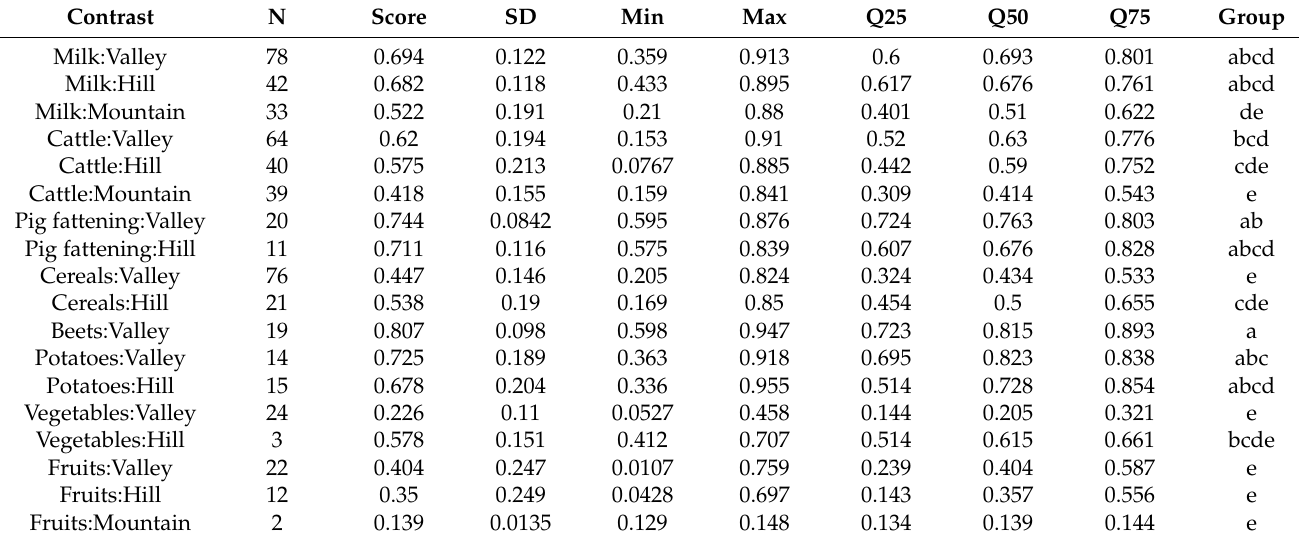
Table A8. Summary two-way ANOVA environmental efficiency. The group column indicates significant differences (i.e., the same letter indicates non–significant differences in variance).